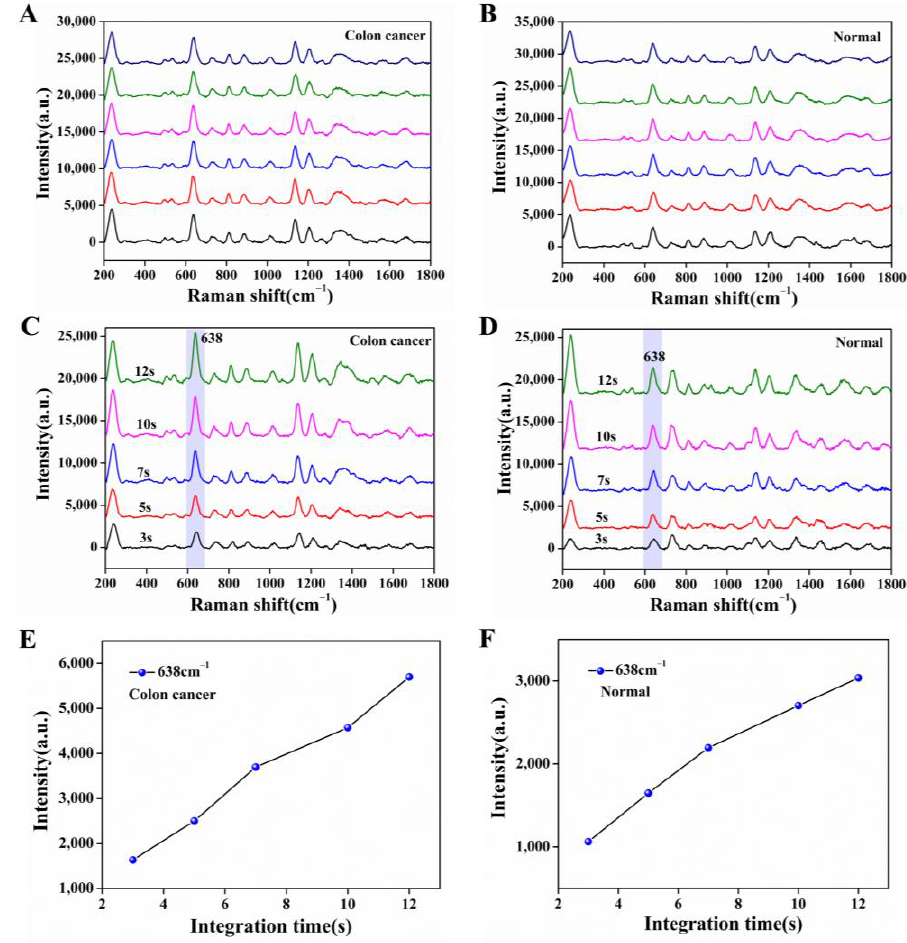
Figure 5. SERS spectra of serum adsorbed on Ag NPs/CNC/GO nanocomposite film at the same site. ( A , B ) respectively represented the colon cancer group and the normal group tested six times in parallel under the same laser conditions (laser power (15 mW), irradiation time (10 s); ( C , D ) were maintained the laser power (15 mW) was constant and only the irradiation time (3 s, 5 s, 7 s, 10 s, 12 s) was changed for the colon cancer group and normal group. ( E , F ) were corresponding to the SERS intensity of the SERS spectra of ( C , D ) at the characteristic peak 638 cm − 1 , respectively.